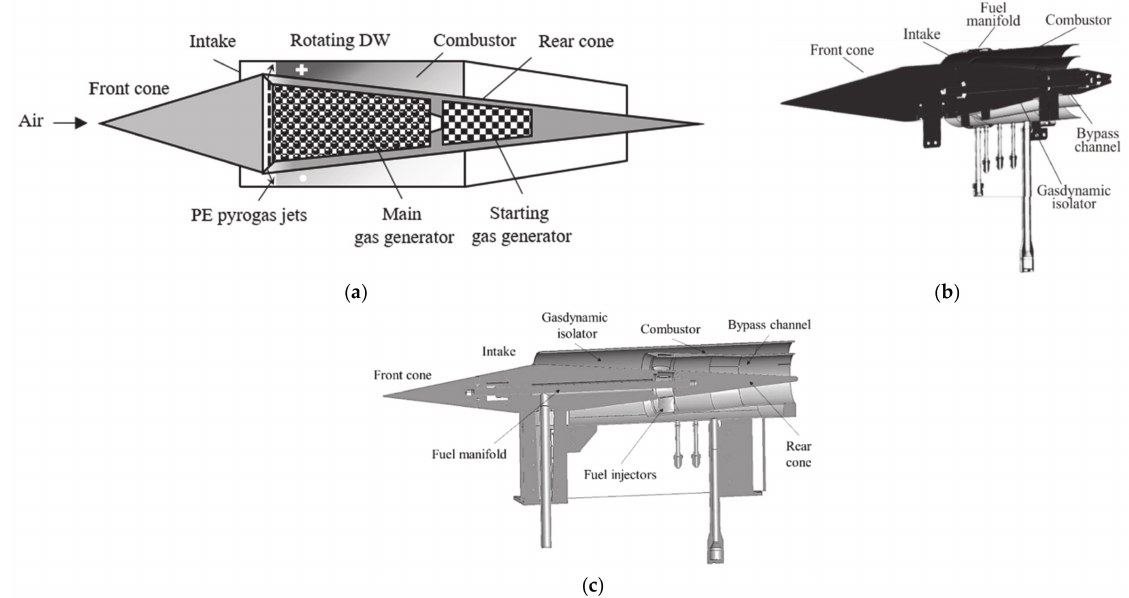
Figure 12. Conceptual designs of ( a ) solid-fuel DR [9], ( b ) hydrogen-fueled dual-duct DR [29,30], and ( c ) ethylene/pyrogas fueled dual-duct DR for the cruising flight speed of Mach 2 at sea